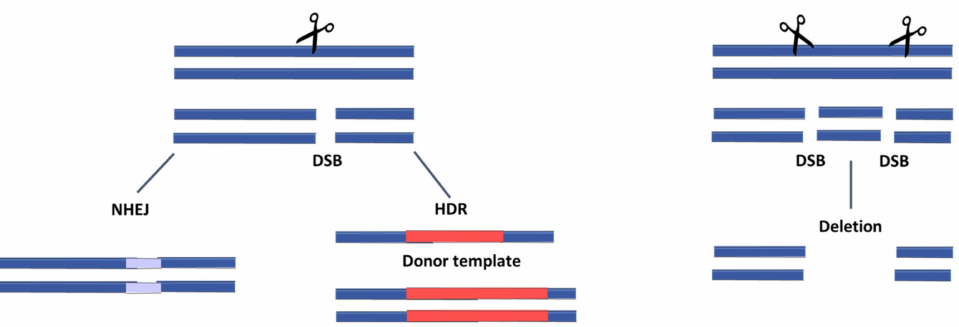
Figure 1. Genome editing strategies: Genome editors induce targeted double-strand breaks (DSB). Single target sites can be repaired by either non-homologous end joining (NHEJ)-generating inserts and deletions or by homology-directed repair (HDR). By providing a donor template, the desired sequence can be integrated via HDR. Large deletions can be induced by cleaving two target sites in the locus of